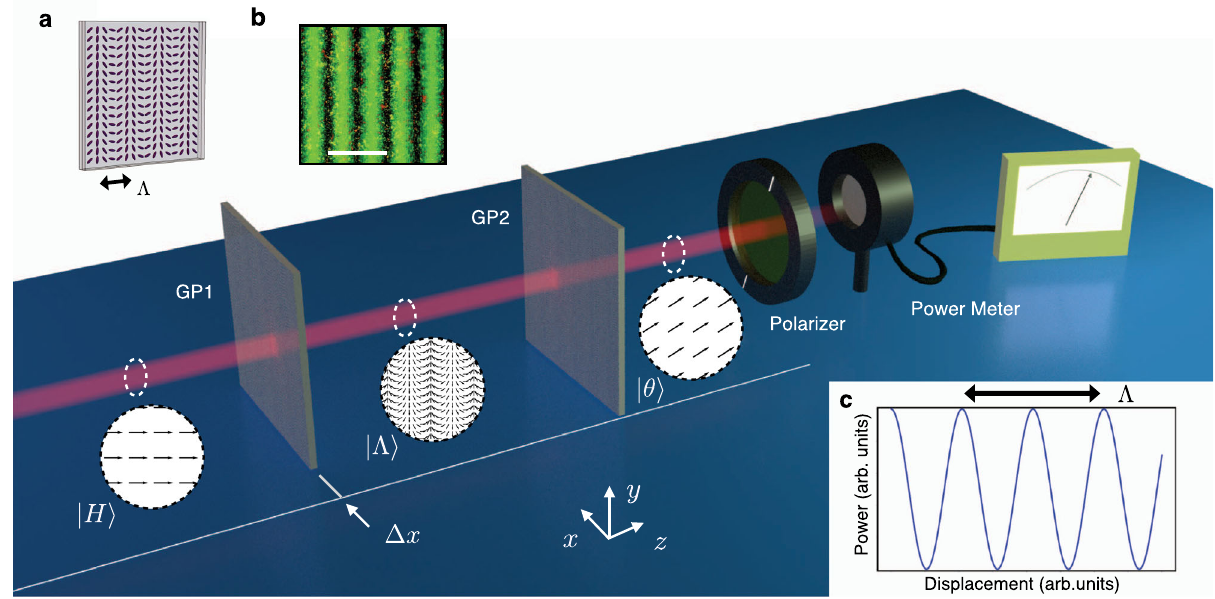
Fig. 1 Linear gears concept. A laser beam, linearly polarized along the horizontal direction, is transformed by a g -plate (GP1) into a structured light beam Λ j i . A second g -plate (GP2), identical to GP1, transforms back the polarization mode into a linearly polarized homogeneous one ( θ j i ), rotated by an angle Δ θ with respect to the input polarization direction. Dashed circles represent the polarization state in three different positions along the laser beam corresponding to H j i , Λ j i , and θ j i , respectively. By monitoring the optical power after a linear polarizer, one can track the transverse displacement Δ x . a g - plate geometry, purple lines represent the orientation of the liquid-crystal molecular director inside the cell. The spatial period is set by the parameter Λ . b Micrograph of a g -plate with Λ = 50 μ m placed between two linear polarizers. The scale bar corresponds to 50 μ m. c Super-resolving Malus ’ law for the linear photonic gear.